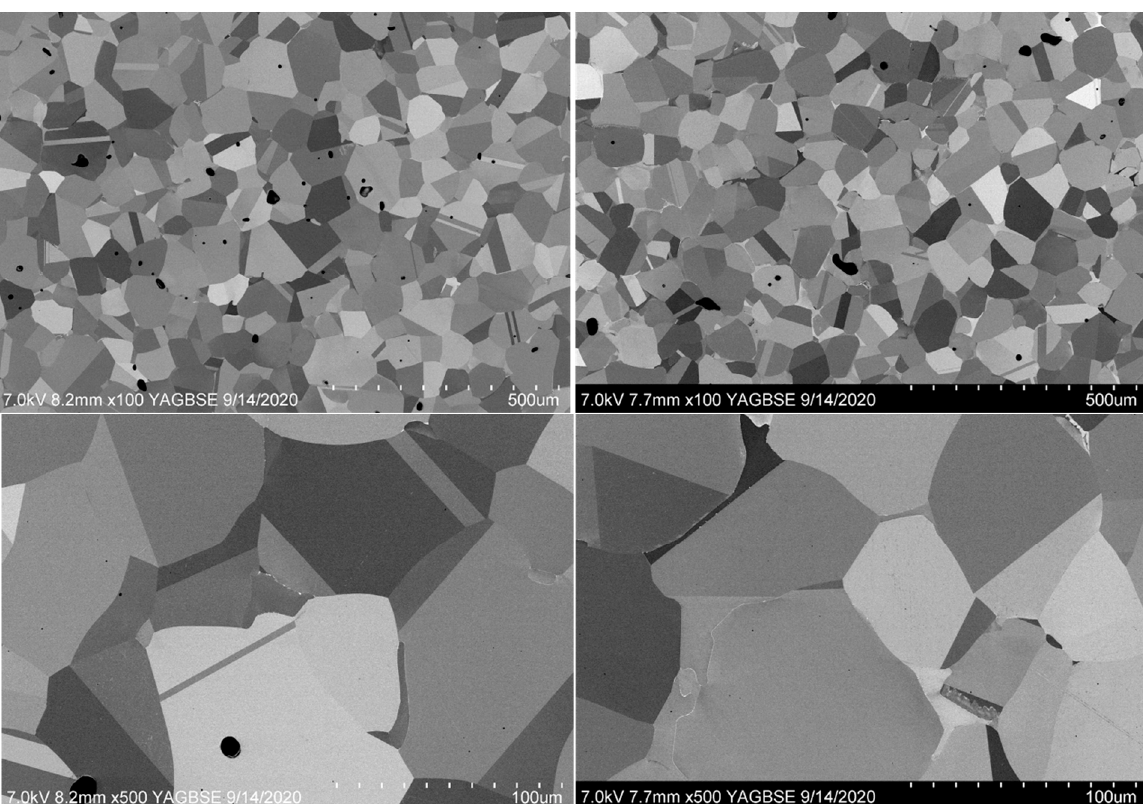
Figure 9. Backscattered electron images of as-sintered coupons from Build 1 (baseline-left top and bottom) and Build 2 with a faster cooling rate (right-top and bottom).